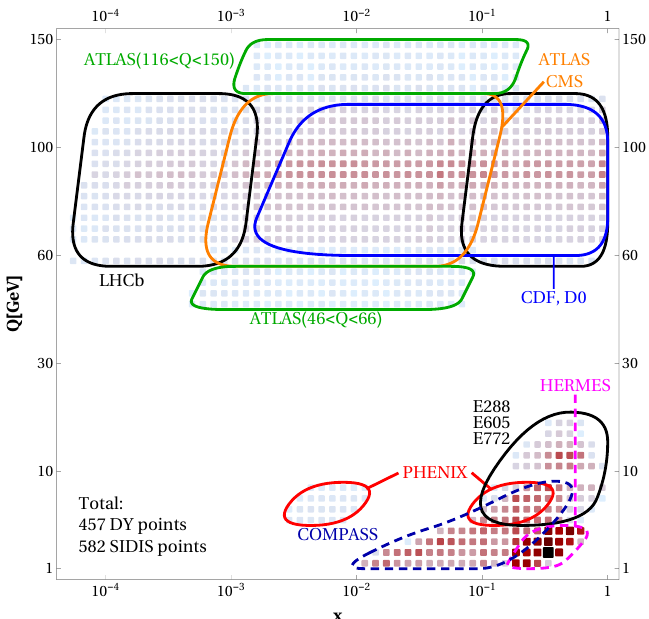
Figure 5 . Density of data in the plane ( Q; x ) (a darker color corresponds to a higher